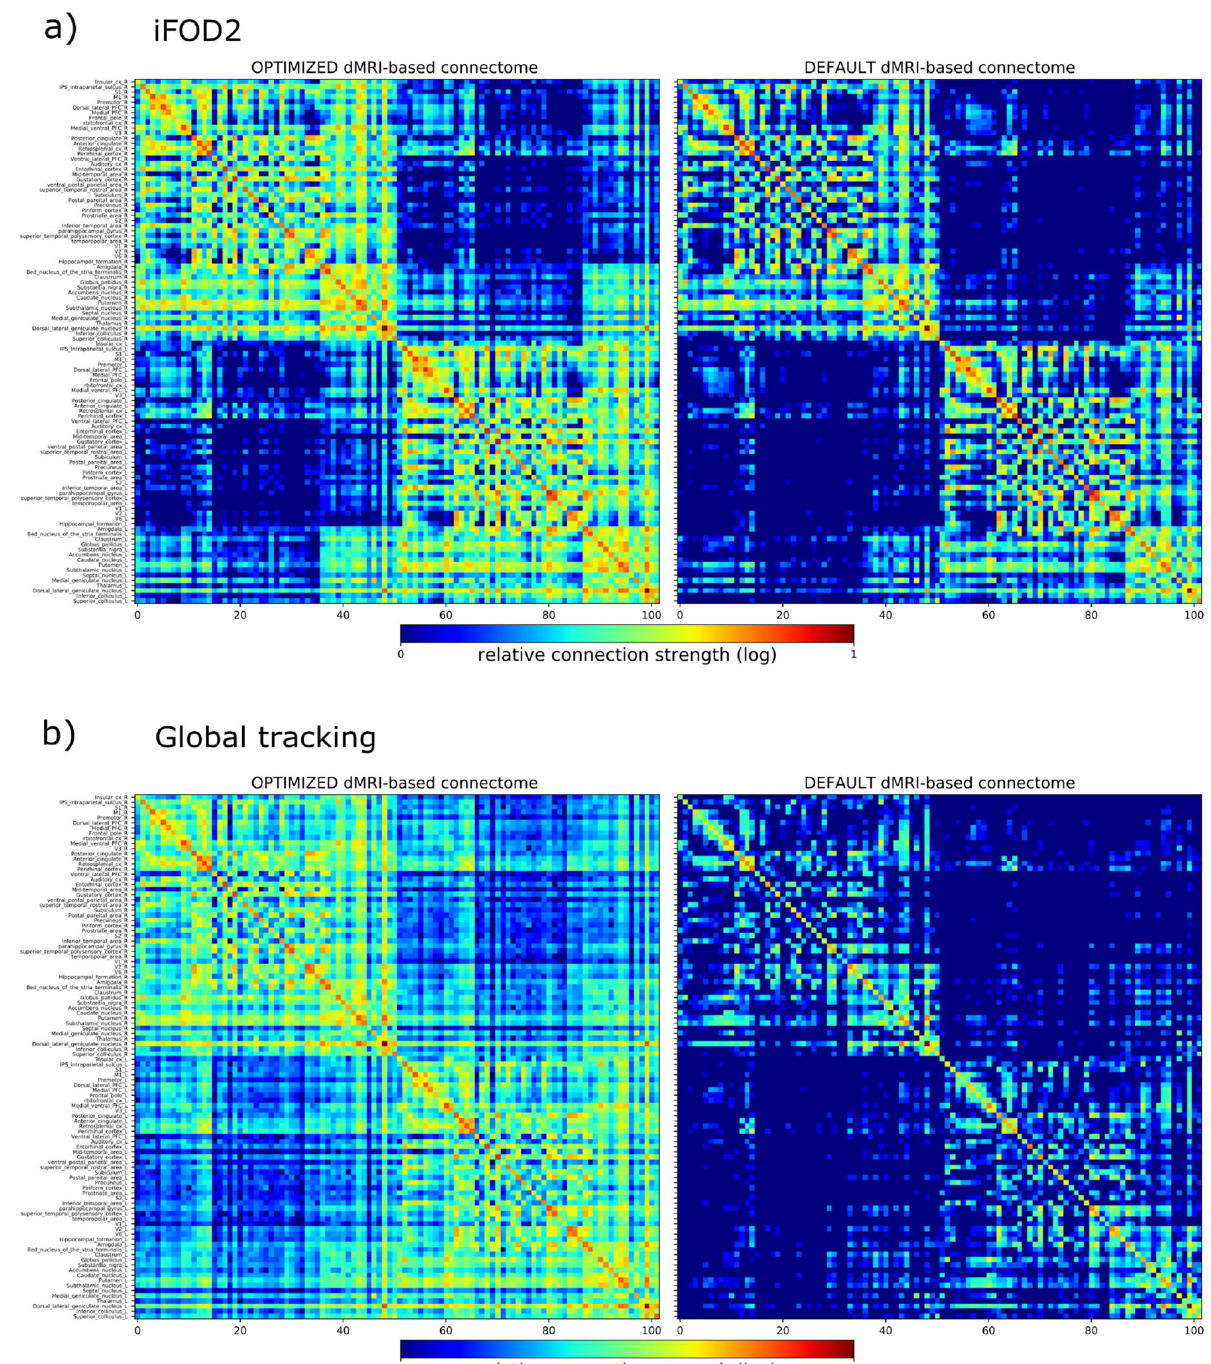
Figure 7. Whole-brain dMRI-based optimized and default connectomes. Square dMRI-based matrix comparison for one brain-subject example, using optimized (left) and default (right) parameters for ( a ) iFOD2 and ( b ) global tracking